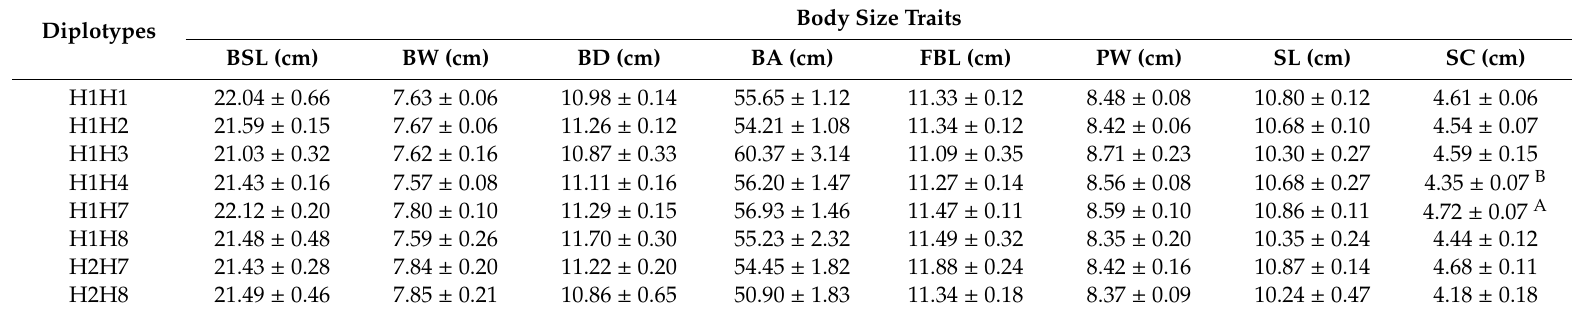
Table 7. Association of diplotypes of the PITX2 gene with body size traits in Wuliang Mountain Black-bone chickens ( MEAN ± SE ).